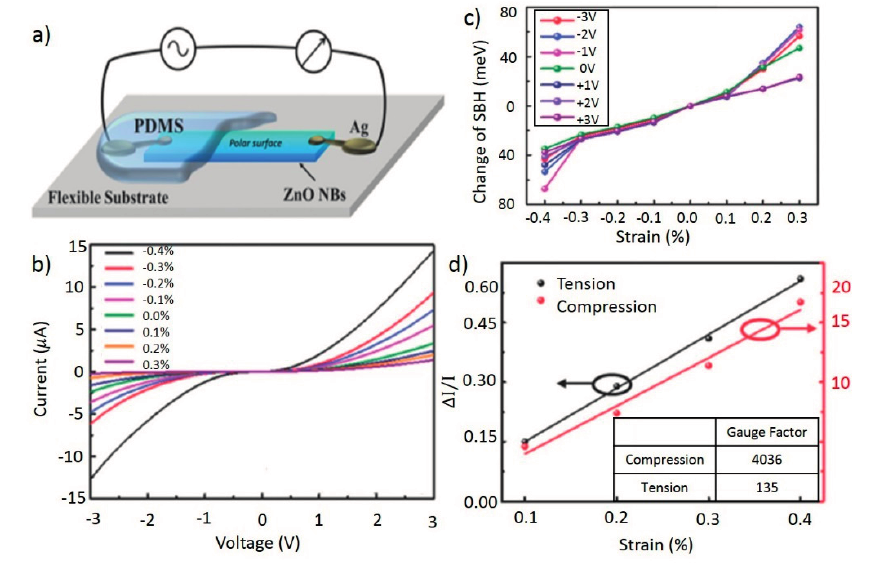
Figure 3. ( a ) Schematic diagram of the device; ( b ) Current-voltage curves as a function of strain; ( c ) Schottky barrier height change as a function of bias for varying strains; Inset